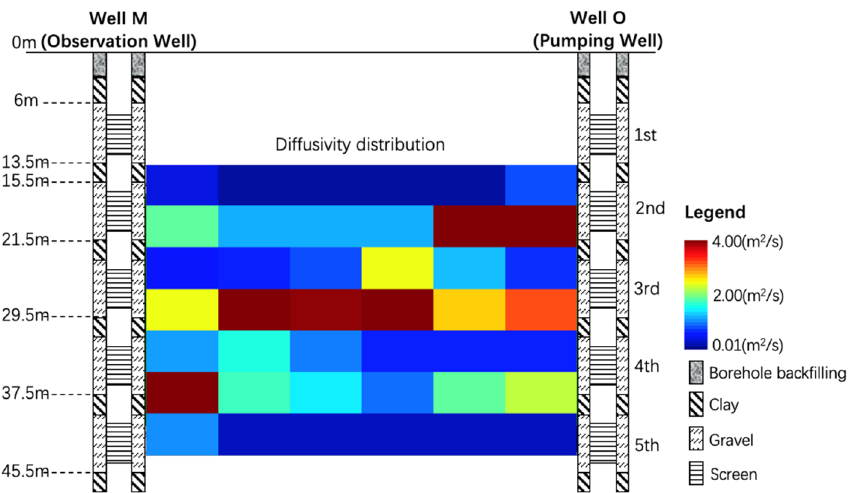
Figure 16. Diffusivity distribution obtained from travel-time based inversion. Figure 16. Di ff usivity distribution obtained from travel-time based inversion.